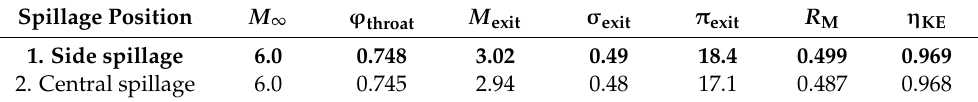
Table 2. Aerodynamic characteristics of bump inlets at M ∞ = 6.0 and H = 24 km.